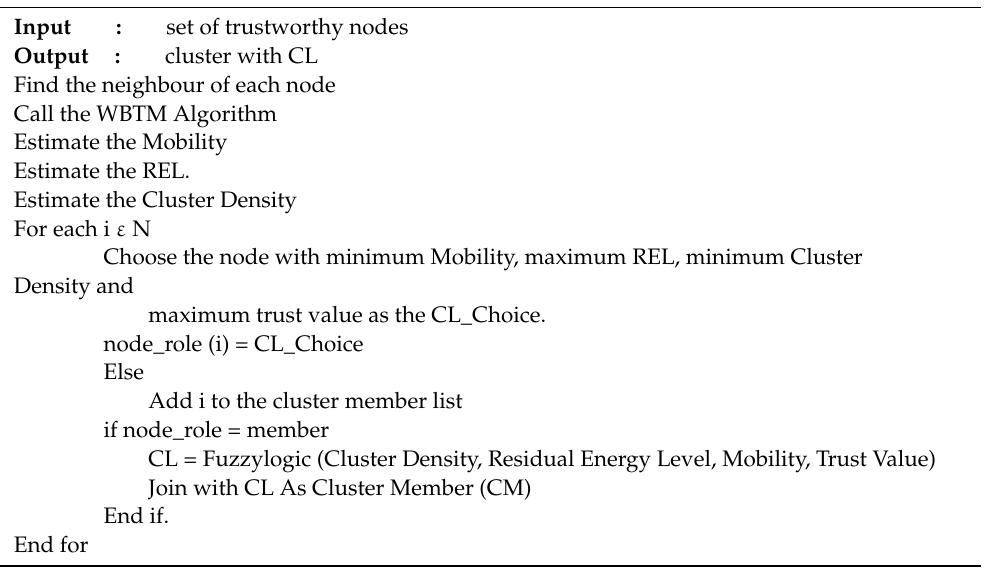
Algorithm 2 Fuzzy-Based Clustering (FBC)